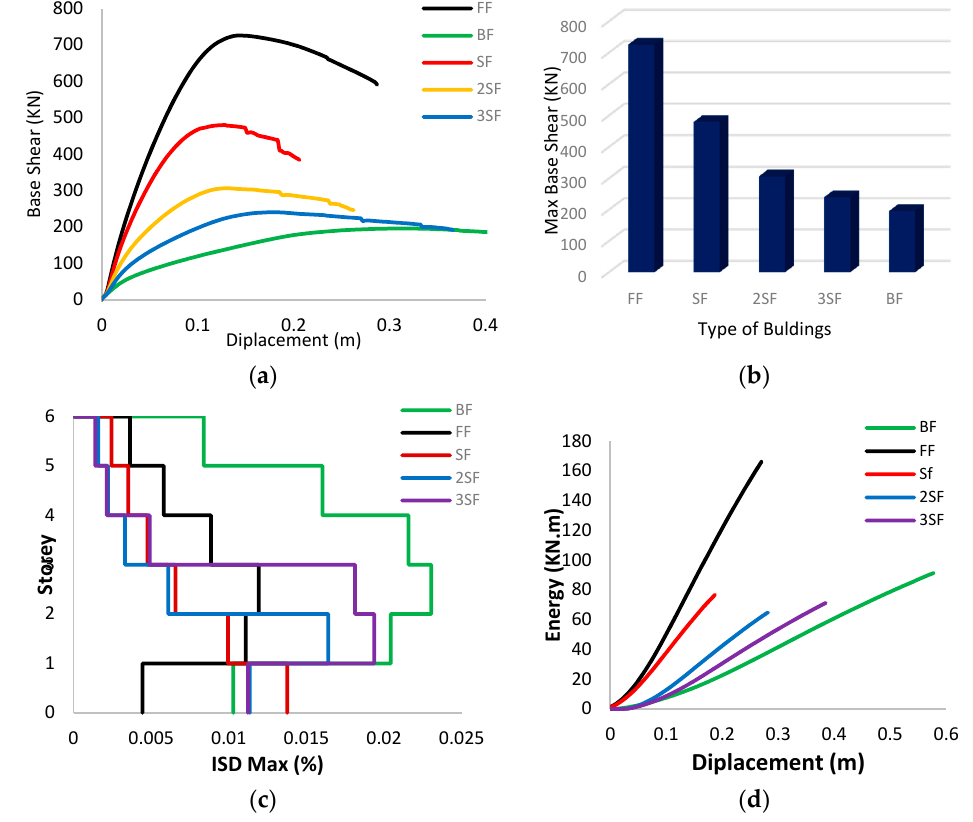
Figure 8. Case N ◦ :1: ( a ) the capacity curve, ( b ) the maxillary base shear values, ( c ) the maximum ISD, ( d ) the energy absorbed curve of the